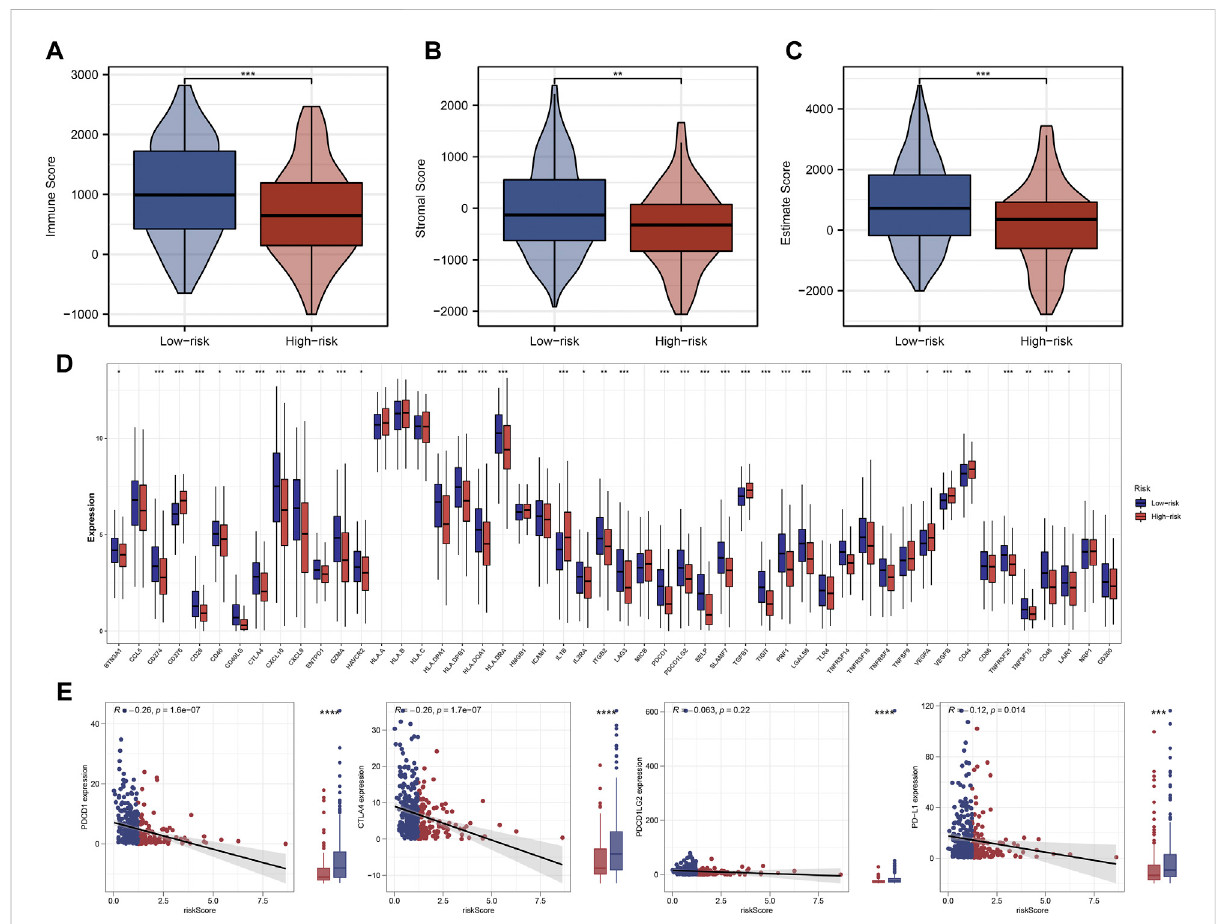
FIGURE 8 Signi fi cant difference of immunity features between two groups. Notes: (A – C) Patients with low riskscore had higher immune scores, stromal scores and estimate scores compared with patients with high riskscore. (D) Differences in expression of 50 common immune-checkpoint – relevant genes between two the groups. (E) Correlations analysis showed that riskscore negatively correlated with CTLA4 and PD-1